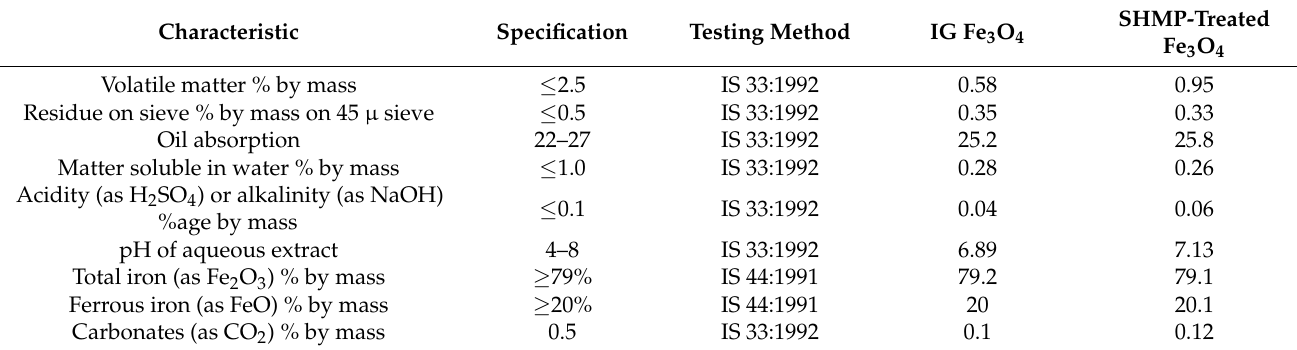
Table 1. Chemical characteristics of IG Fe 3 O 4 and SHMP-treated Fe 3 O 4